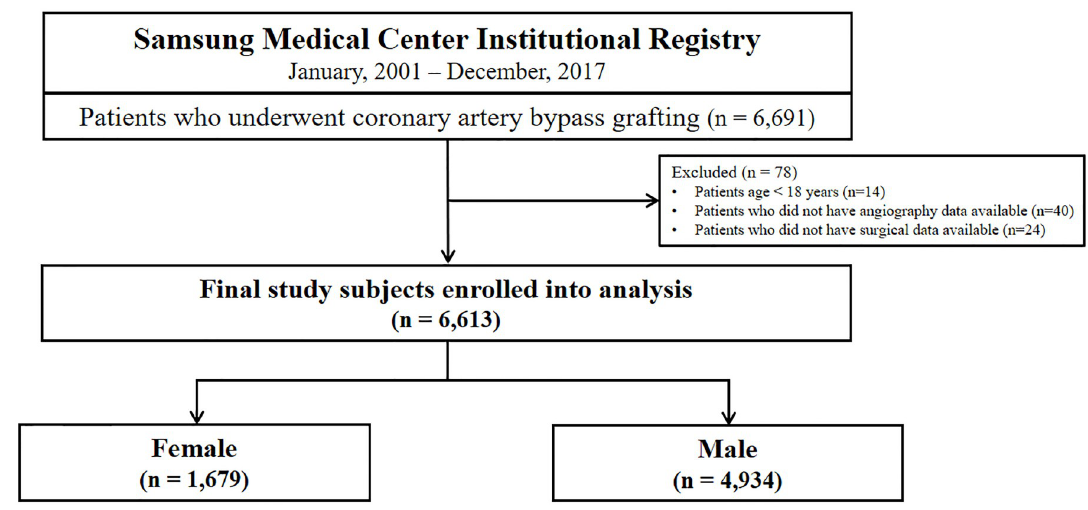
Fig 1. Study flow